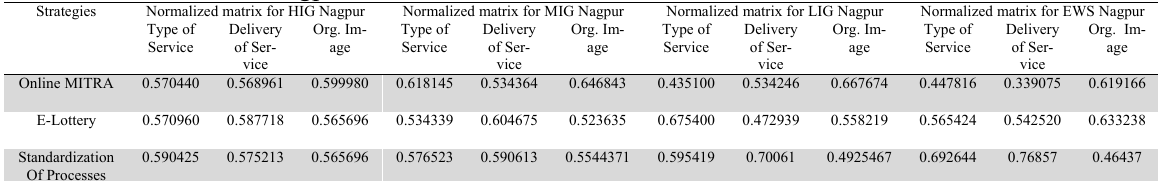
Normalized matrix for Nagpur Board Strategies